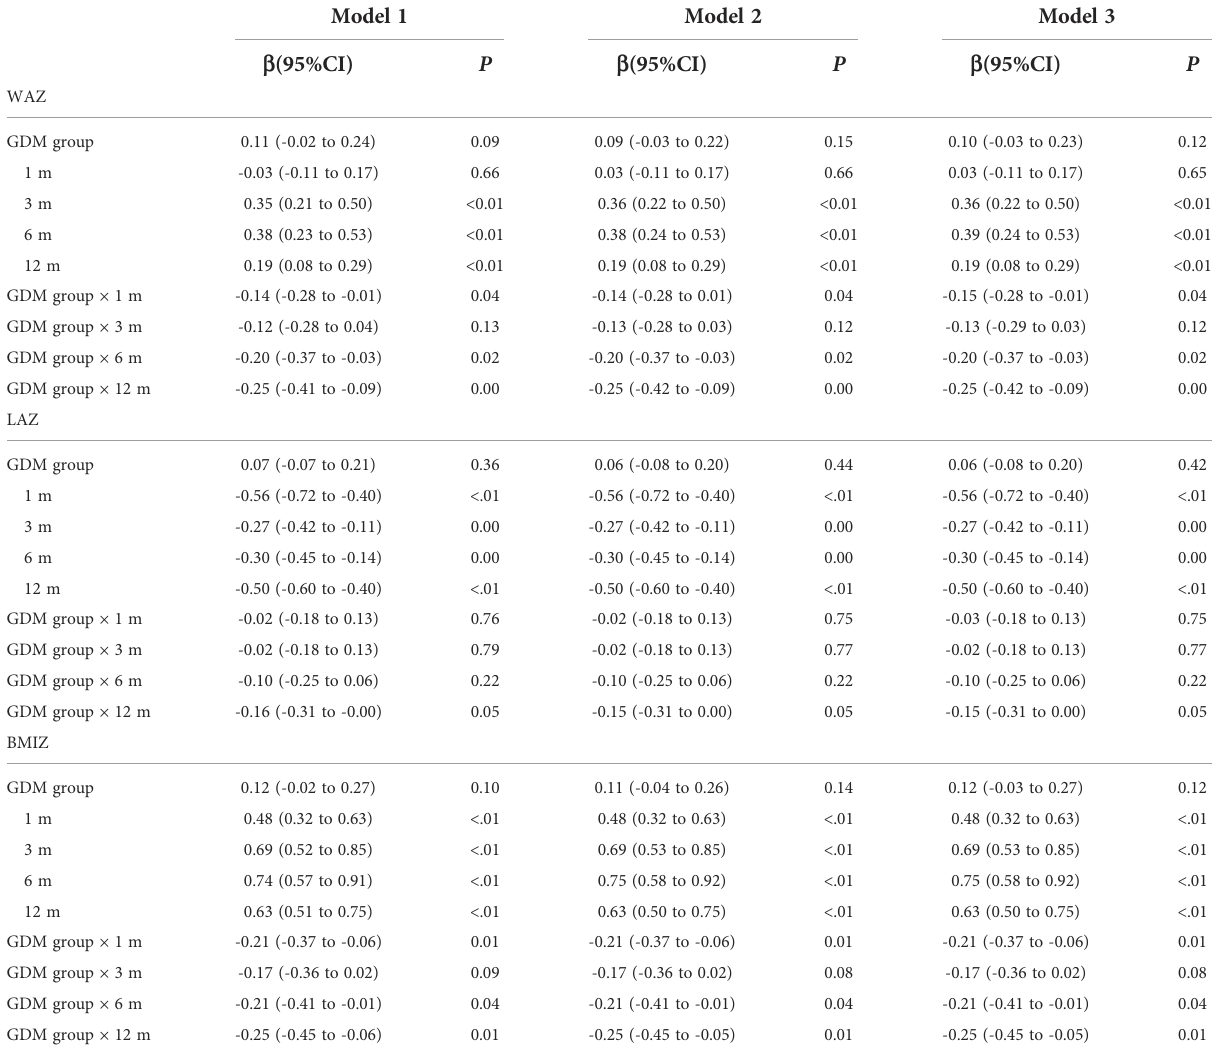
TABLE 4 Linear mixed-effect models of